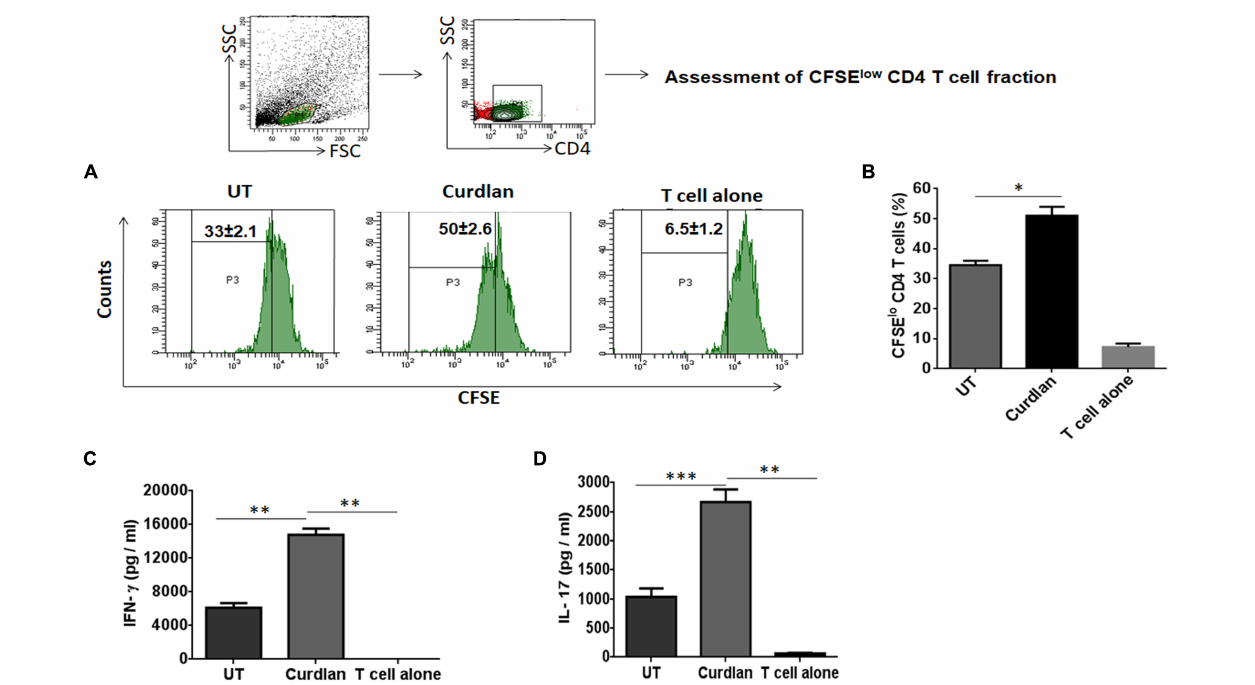
FIGURE 3 | Stimulation of Mtb infected M (cid:56) s with curdlan activate Mtb antigen-specific T cells. M (cid:56) s were infected with Mtb (MOI = 5) and stimulated with curdlan (50 µ g/ml) for 48 h, followed by their co-culture with CFSE (2 µ M) labeled CD4 T cells (MACS sorted from spleen of Mtb infected mice) in the presence of PPD (25 µ g/ml) at a ratio of 1:10. (A,B) After 72 h, CD4 T cells proliferation was monitored by flow cytometry. First gate (P1) was made in live lymphocyte zone followed by gating on CD4 T cells to assess cell proliferation. Data in the inset of flow cytometry plot and bar graph indicate percentage of proliferating CD4 T cells (CFSE lo ). Further, (C,D) IFN- γ and IL-17 were measured in the culture SNs by ELISA. UT, Mtb infected M (cid:56) s (not stimulated with curdlan); Curdlan: Mtb infected and curdlan stimulated M (cid:56) s. Data represented as mean ± SD are representative from two independent experiments. ∗ p ≤ 0.05, ∗∗ p ≤ 0.01, ∗∗∗ p ≤ 0.001.